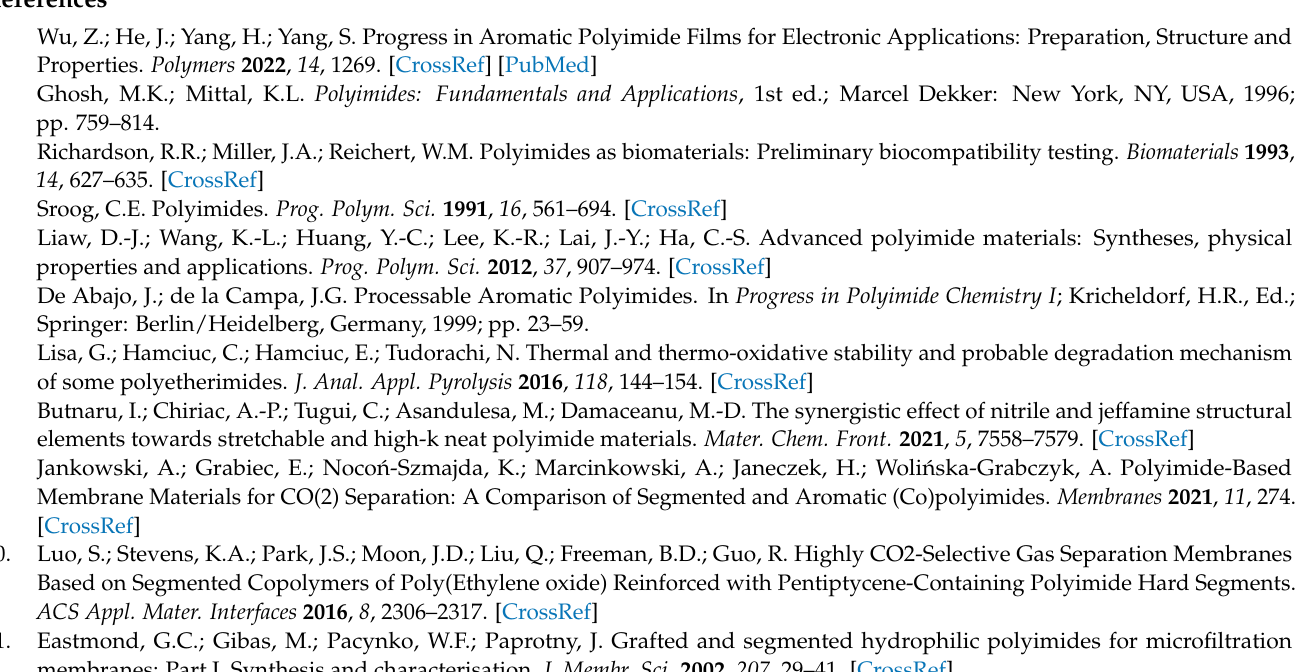
Figure S6: Variation of ion current with temperature for fragments m/z = 18, m/z = 28, m/z = 30 and m/z = 44 if thermal decomposition occurs in nitrogen; Figure S7: Variation of ion current with temperature for fragments m/z = 78, m/z = 91, m/z = 94 and m/z = 108 if thermal decomposition occurs in nitrogen; Figure S8: Variation of ion current with temperature for fragments m/z = 103 for thermal decomposition in nitrogen; Figure S9: Variation of ion current with temperature for fragments m/z = 18, m/z = 28, m/z = 30 and m/z = 44 for thermal decomposition in air; Figure S10: Variation of ion current with temperature for fragments m/z = 78, m/z = 91, m/z = 94 s i m/z = 108 for thermal , decomposition in air; Figure S11: Variation of ion current by temperature for the fragments m/z = 58, m/z = 73, m/z = 15 and m/z = 46 if thermal decomposition occurs in nitrogen; Figure S12: Variation of ion current with temperature for fragments m/z = 58, m/z = 73, m/z = 15 and m/z = 46 if thermal decomposition occurs in air; Figure S13: Variation of ion current with temperature for fragments m/z = 103 for thermal decomposition in